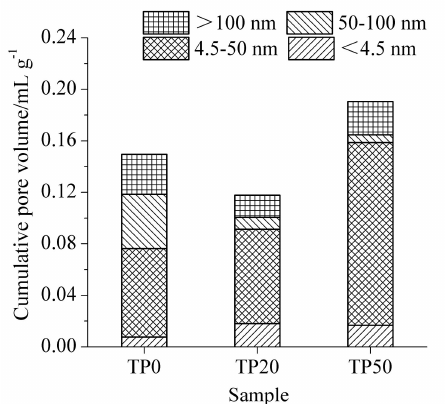
Figure 6. Pore structure of cement-ITP hardened paste cured for 365 days at 20 ◦ C.